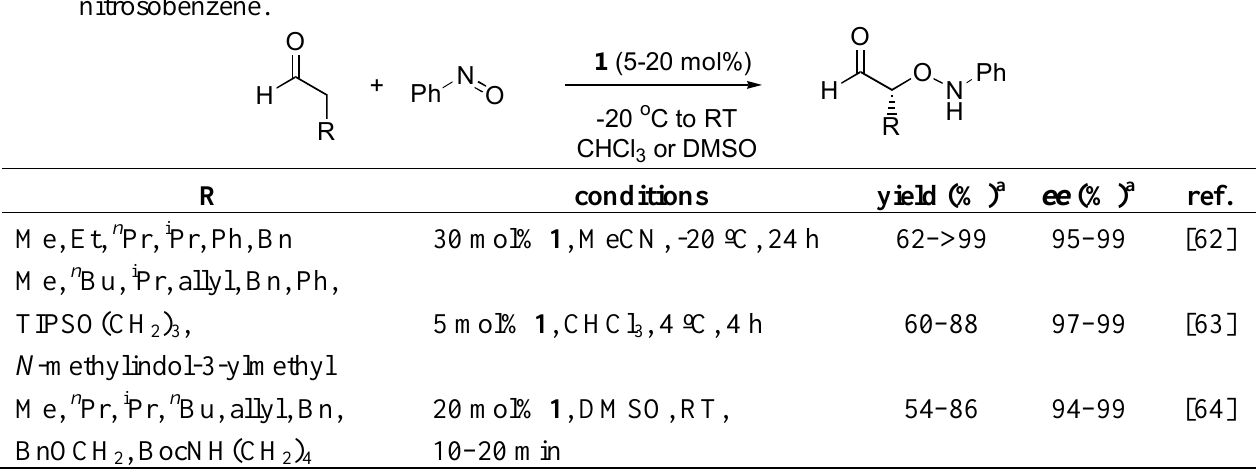
Table 6. Substrate scopes for L -proline-catalyzed  -aminoxylation of aldehydes with nitrosobenzene.